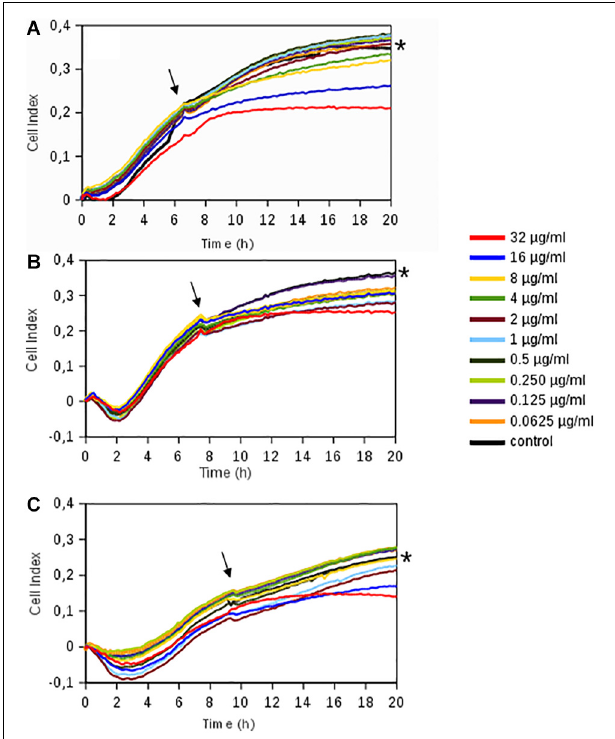
FIGURE 3 | Dalbavancin effect on established staphylococcal biofilms in Staphylococcus aureus 240 (A) , S. aureus MRSA4 (B) , and Staphylococcus epidermidis 43040 (C) strains. Dalbavancin was added at the exponential growth phase of the biofilm (marked by black arrows) at 6 h ( S. aureus 240), 7 h ( S. aureus MRSA4), or 9 h ( S. epidermidis 43040) at the concentrations shown in the legend. Black asterisks indicate the antibiotic-free cell control. Data are the means of two